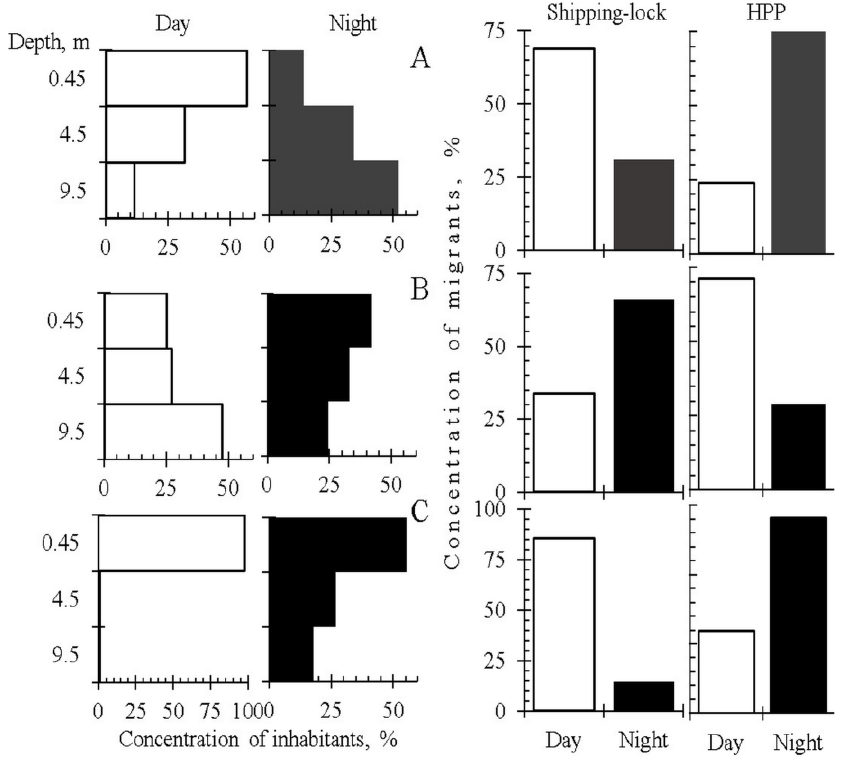
Figure 5. Diel vertical migrations of inhabitants of the pelagic area upstream the dam (left panels) influence relative concentration of migrants through the Sheksninskaya HPP and Shipping-lock water intakes (right panels). ( A ) — zander, ( B ) — smelt, ( C ) — bleak. Relative concentration, % of the total amount, of fish is shown on the horizontal axis (left panels) and on the vertical axis (right panel). Data from [34,37].